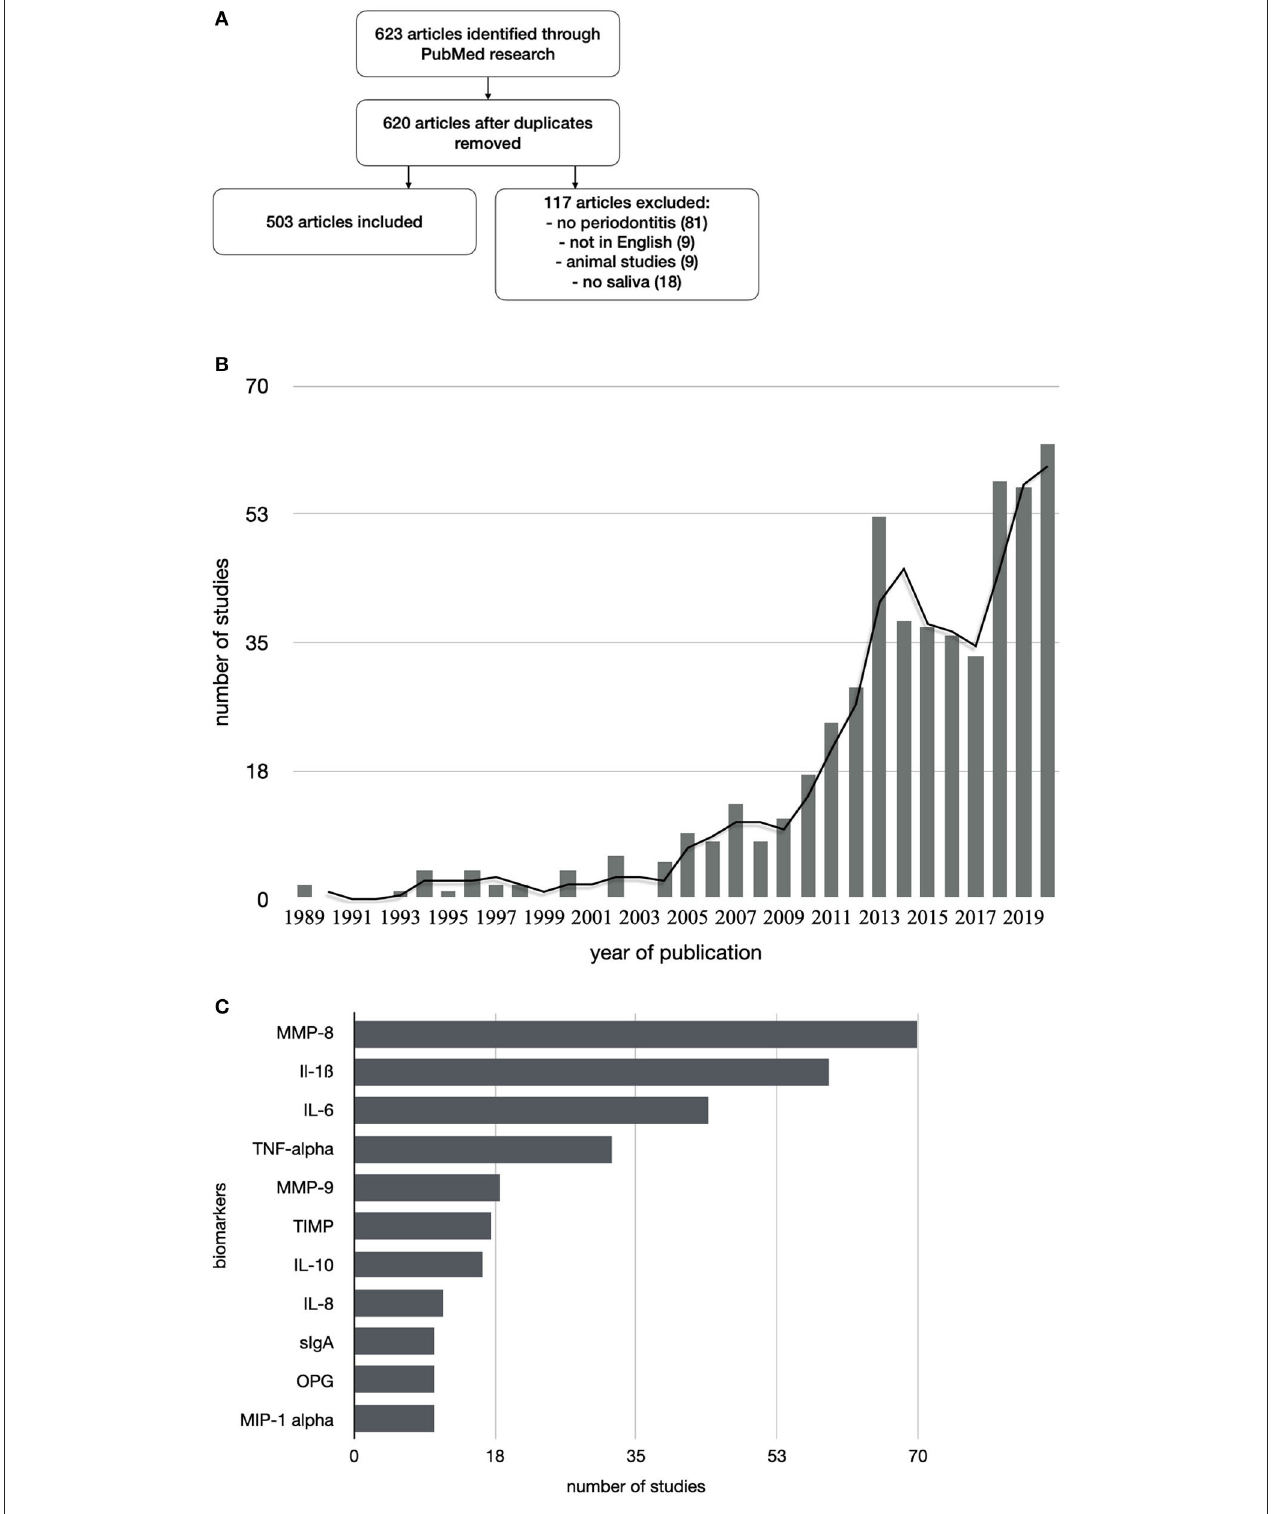
FIGURE 2 | Flowchart of study selection (A) . Increasing numbers of publications about salivary biomarkers and periodontitis over the last 30 years (B) . The best investigated salivary biomarkers for periodontitis are MMP-8 with a total of 70 publications and proinflammatory cytokines (C) .